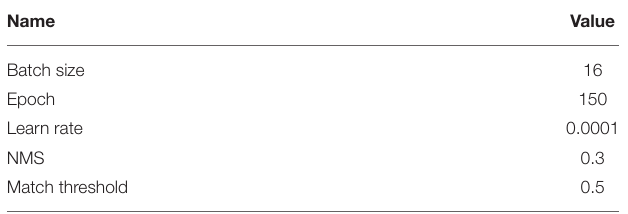
TABLE 2 | Comparison with existing forestry pest datasets.